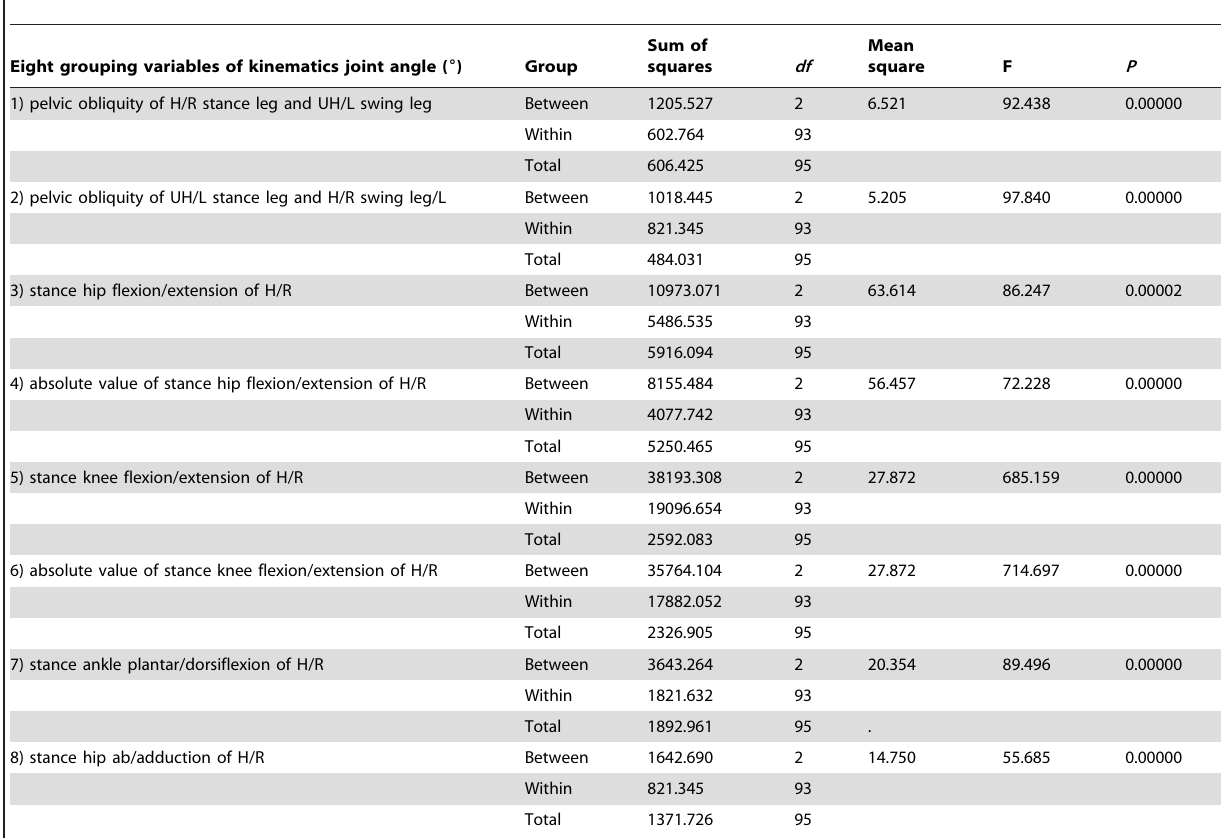
Table 3. Results of analysis of variance (ANOVA). Differences between the means of various clusters for kinematics (joint angles) are